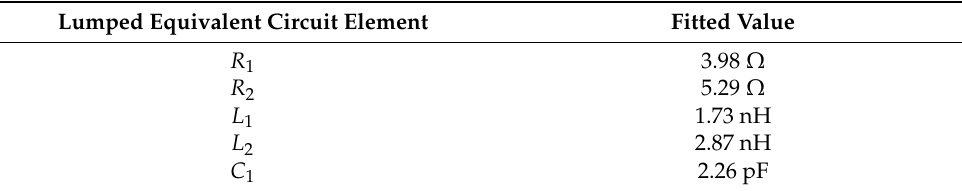
Table 1. Values of the element of the lumped equivalent circuit (Figure 14) obtained by